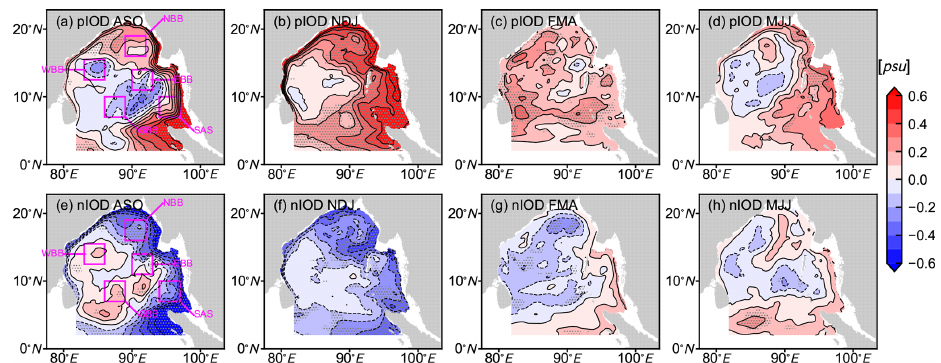
Figure 10. Composite of subsurface (100m) salinity anomalies during ASO (a, e) , NDJ (b, f) , FMA (c, g) , and MJJ (d, h) of pIOD and nIOD years, respectively, from HAMSOM. The contour intervals are 0.1psu. Anomalies significant at the 95% confidence level using a two-tailed Welch’s t test are hatched with grey dots. Selected subareas are marked with magenta boxes in (a) and (e) .